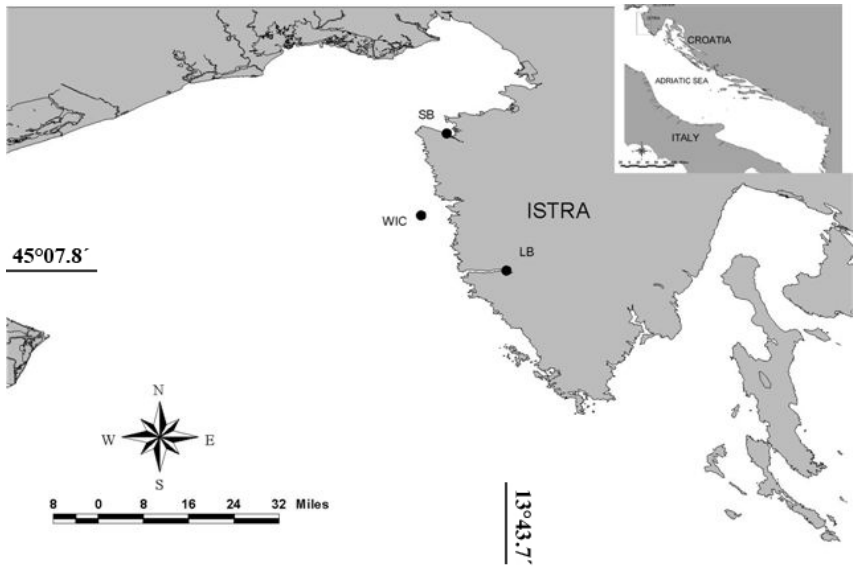
Figure 1. Investigated area with sampling stations.